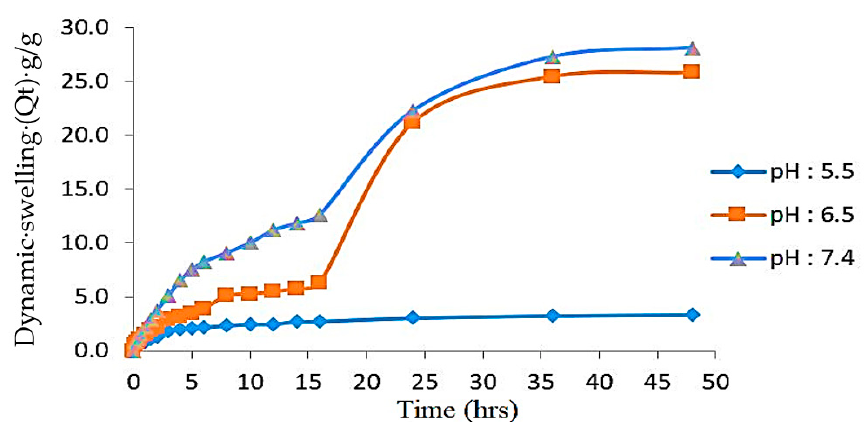
Figure 6. PEGAAM swelling dynamics at different pH levels.